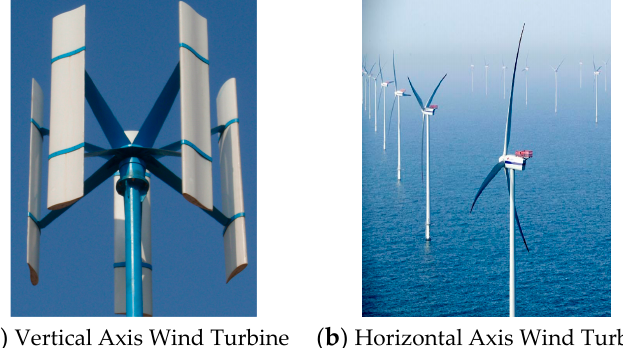
Figure 1. Types of wind turbine.